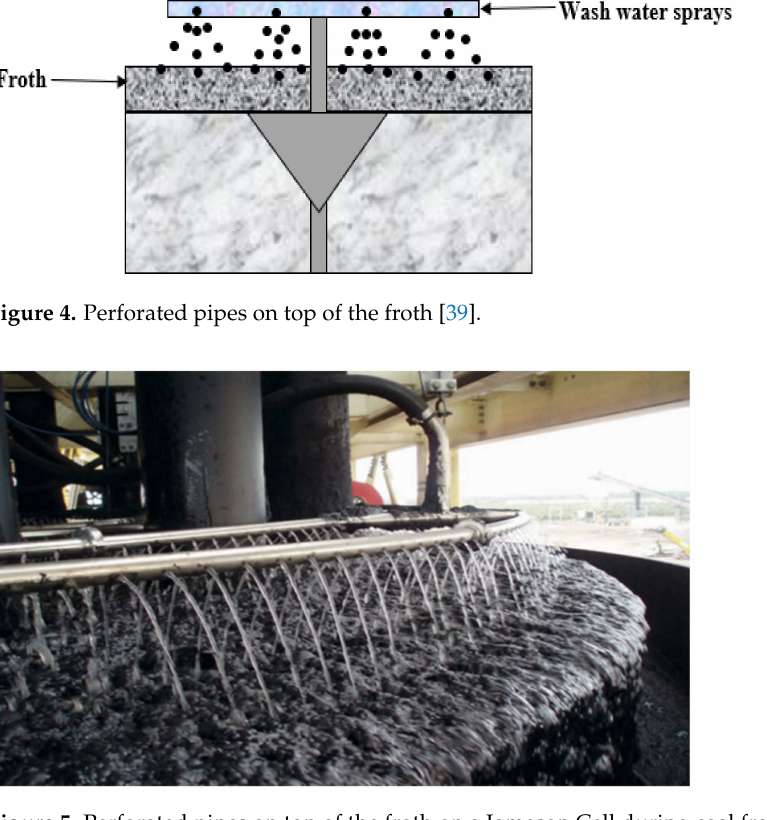
Figure 5. Perforated pipes on top of the froth on a Jameson Cell during coal froth washing